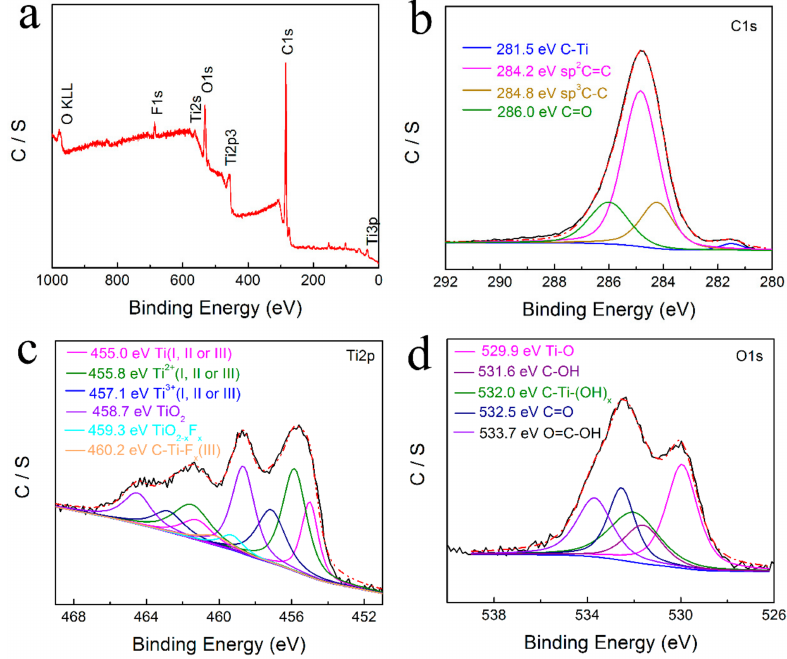
Figure 4. The survey spectrum ( a ) and high-resolution XPS spectra of the C1s ( b ), Ti2p ( c ), and O1s ( d ) peaks of the RGO/Ti 3 C 2